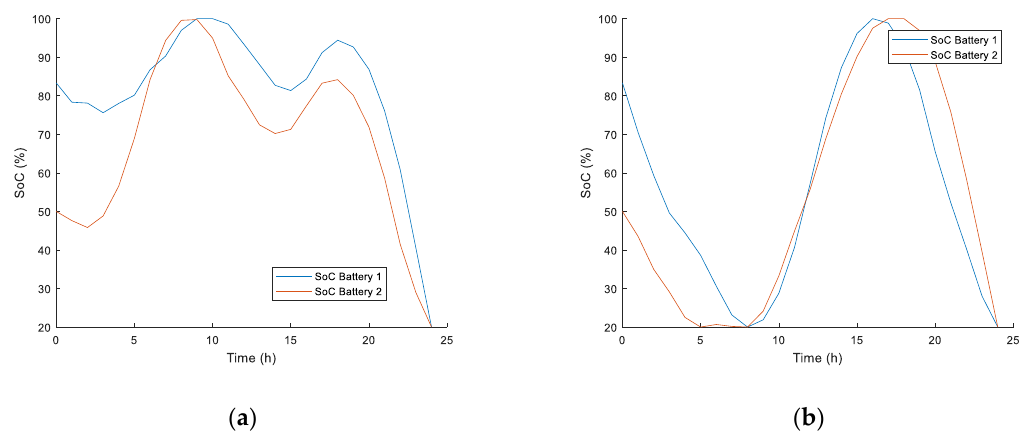
Figure 12. SoC of batteries during scheduled 24 h, in the new case study: ( a ) COF; ( b ) MOF.